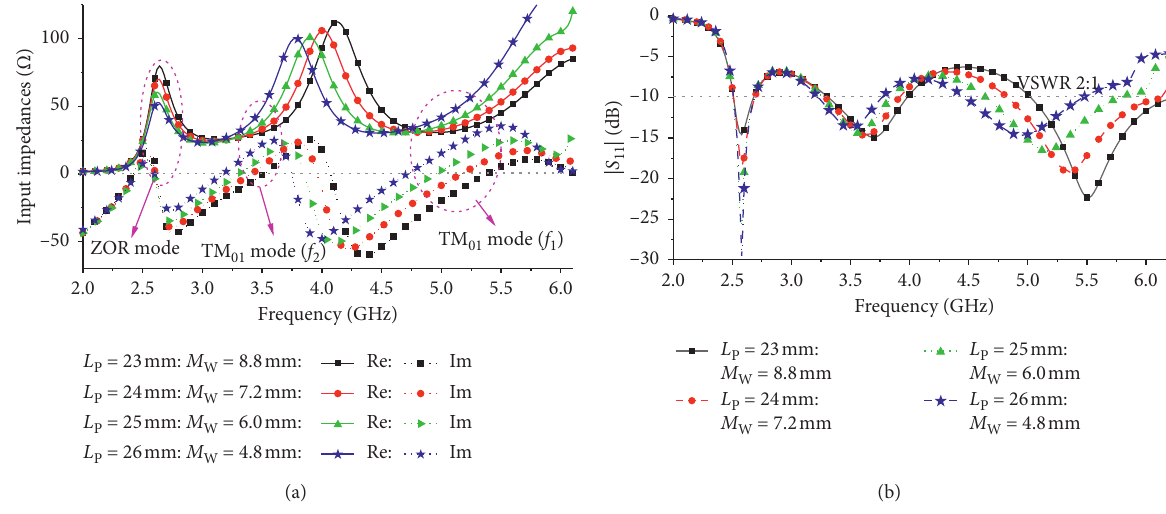
Figure 7: The effects of L P and M W on (a) input impedances and (b) | S 11 | of the proposed patch